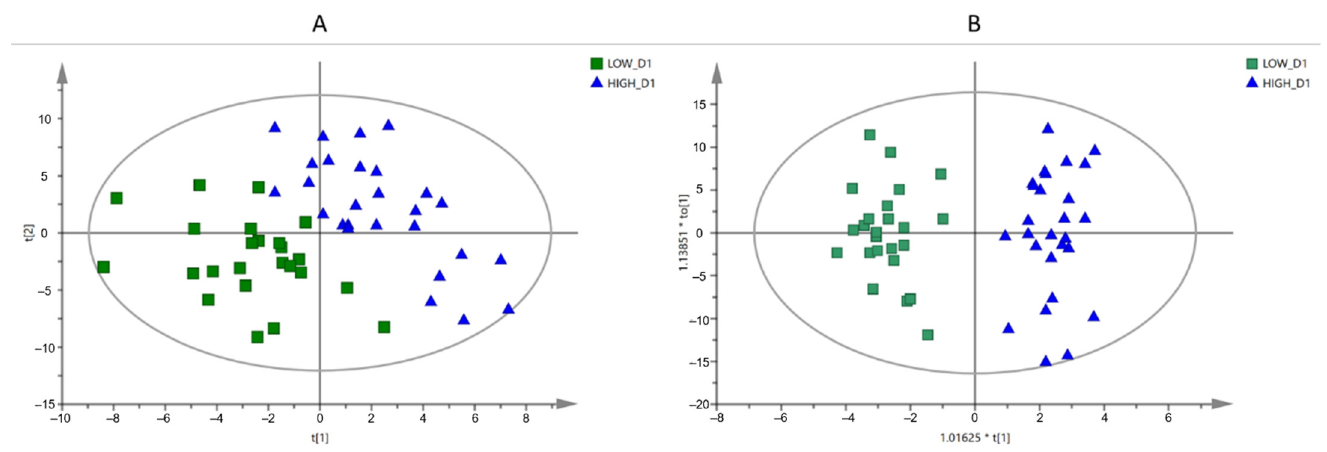
Figure 5. LC–MS Multivariate Analysis. ( A ) Scores plots obtained from the partial least squares- discriminant analysis of ESI ( − ) MS analysis from plasma samples of high vs. low responders after first dose at Day 1 and ( B ) Scores plots obtained from the orthogonal partial least squares-discriminant analysis of ESI ( − ) MS analysis from plasma samples of high vs. low responders after 1st dose at Day 1. Clear clustering is observed between low and high responders: ( (cid:4) ) Low responders at Day 1; ( (cid:78) ) High responders at Day